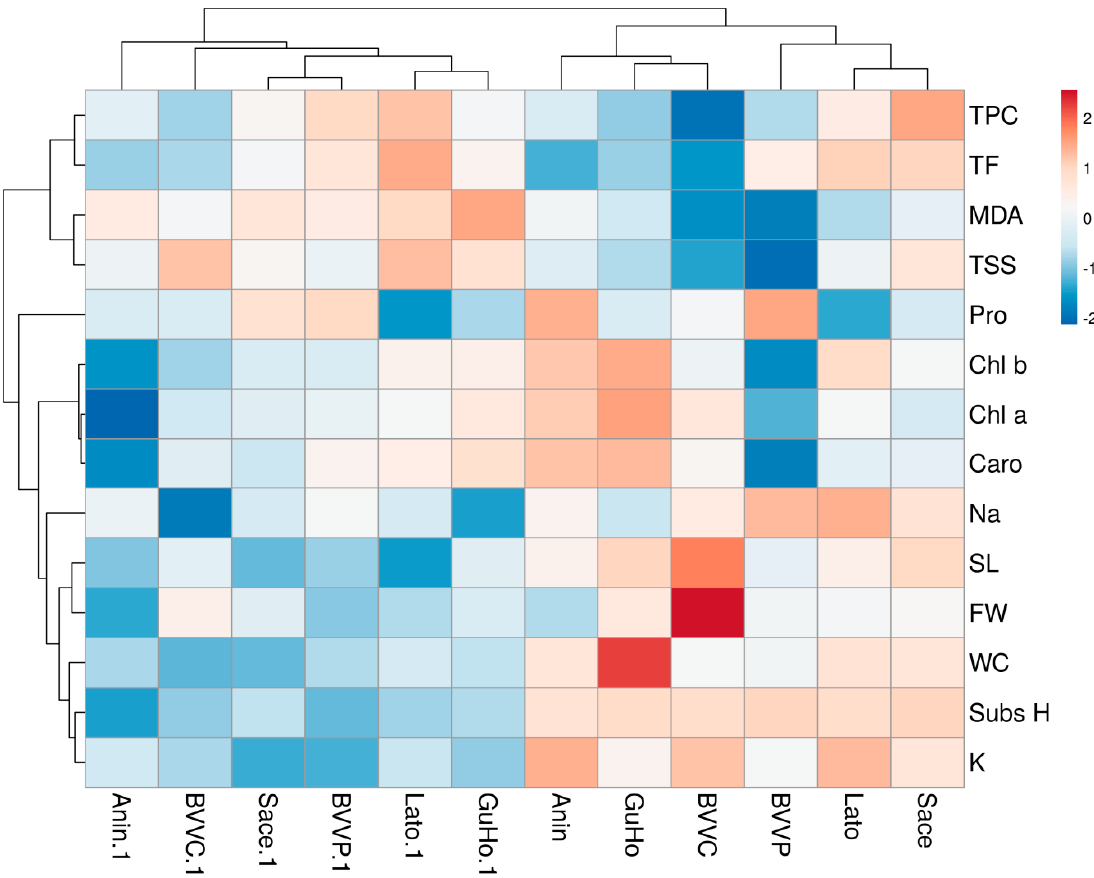
Figure 9. Hierarchical cluster analysis and heatmap of physiological and biochemical parameters in relation to substrate humidity measured in six Romanian provenances of L. decidua . SubsH, substrate humidity; SL, stem length; FW, fresh weight; WC, water content; Pro, proline; TSS, total soluble sugars; Na, sodium; Chl a, chlorohyll a; Chl b, chlorohyll b; Caro, carotenoids; MDA, malondialdehyde; TPC, total phenloc compounds; TF, total flavonoids.